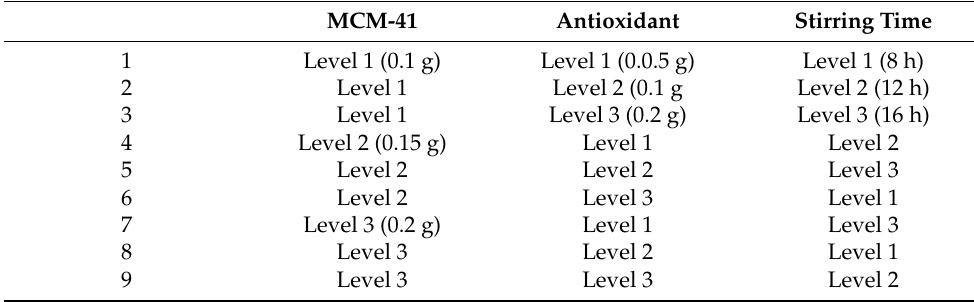
Table 2. Assembling preparation process conditions in orthogonal